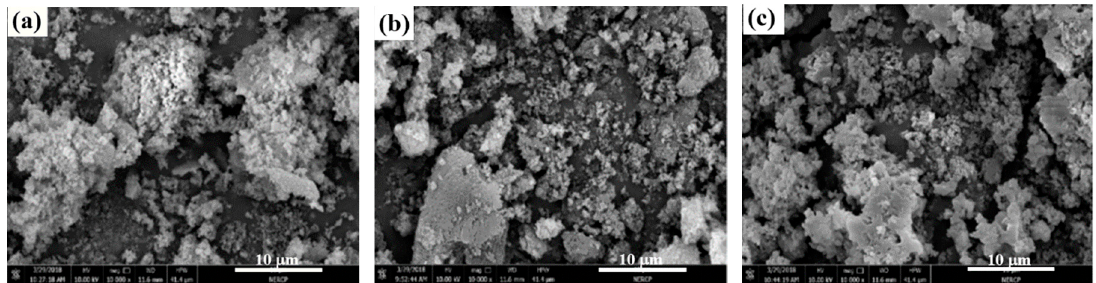
Figure 7. SEM photos of ( a ) Ac-lignin, ( b ) At-lignin, ( c ) By-lignin.